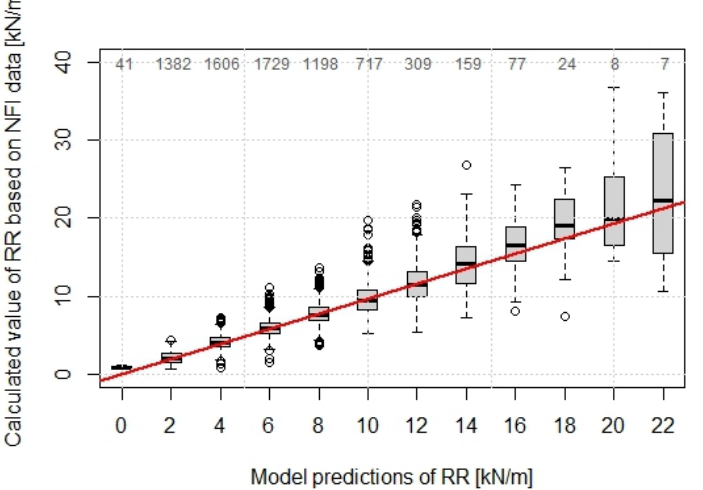
Figure 5. Predicted values of RR using the Weibull RR-model compared with the calculated values based on Swiss NFI. The numbers on the top show the sample size of each box. The red line shows the 1:1 fitting.